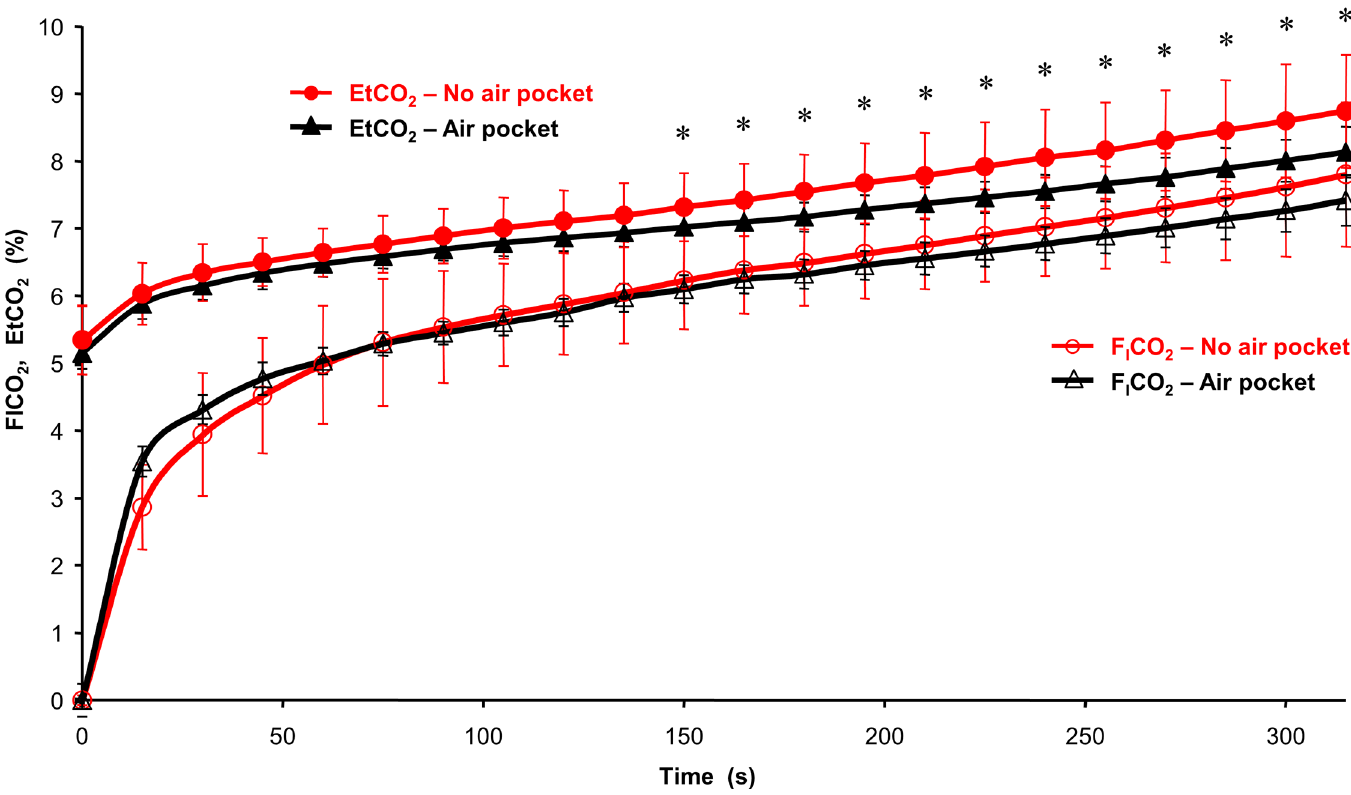
Fig 6. The courses of inspiratory (F I CO 2 ) and end-tidal (EtCO 2 ) fractions of carbon dioxide in the breathing gas during NP and AP phases. The symbol * represents statistically significant differences in EtCO 2 between the NP and AP groups; p (cid:1) 0.05.